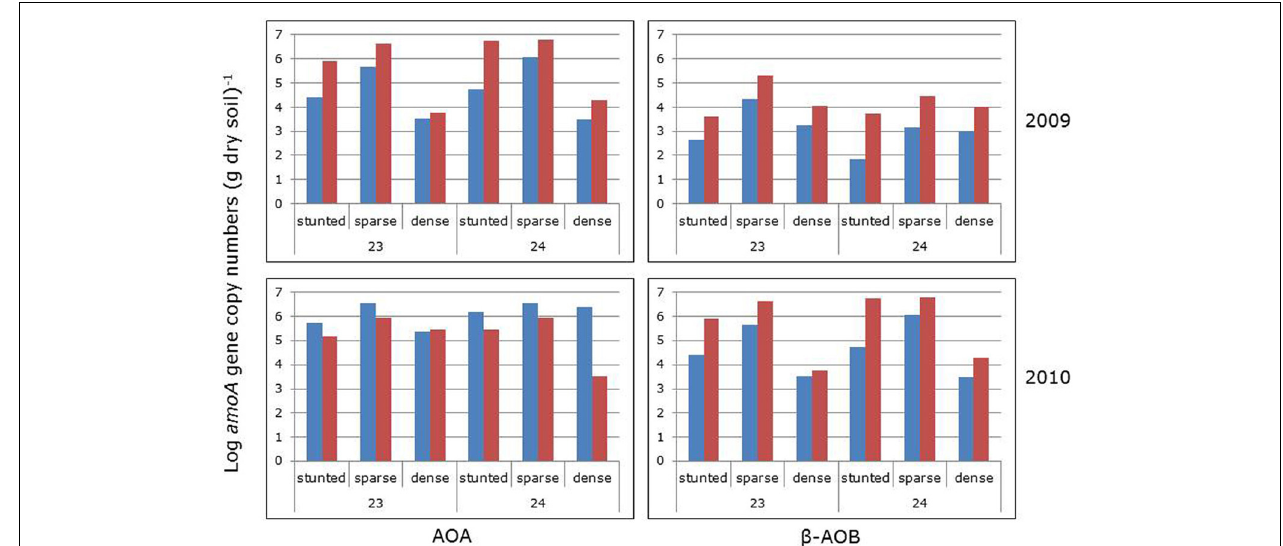
FIGURE 4 | Archaeal (left panels) and bacterial (right panels) amoA gene copy numbers (numbers per g dry soil) before (blue bars) and after (red bars) prolonged incubation of 6 days with added ammonium in the absence (2009 series) and presence (2010 series)